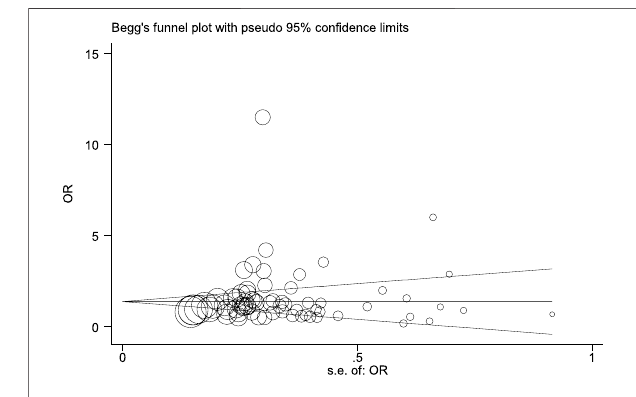
FIGURE 15 | Funnel, Eagers ’ , & Beggs ’ plots for assessment of publication